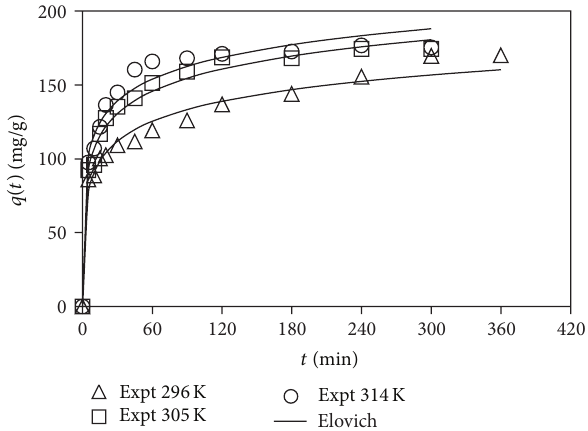
Figure 11: Effect of temperature on batch kinetics for sorption of glutaraldehyde on EDA-AC. 𝐶 𝑜 : 150 mg/L; 0.8 g/L AC; pH 11.56 ± 0.03 ; − 425 + 300 𝜇 m.